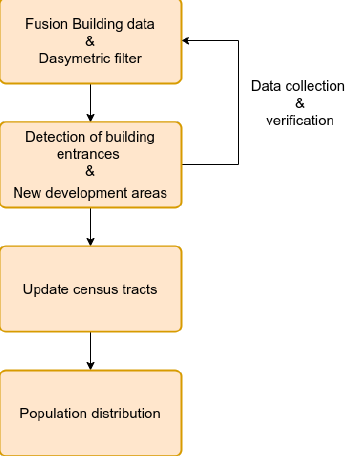
Figure 4. Overview procedure.